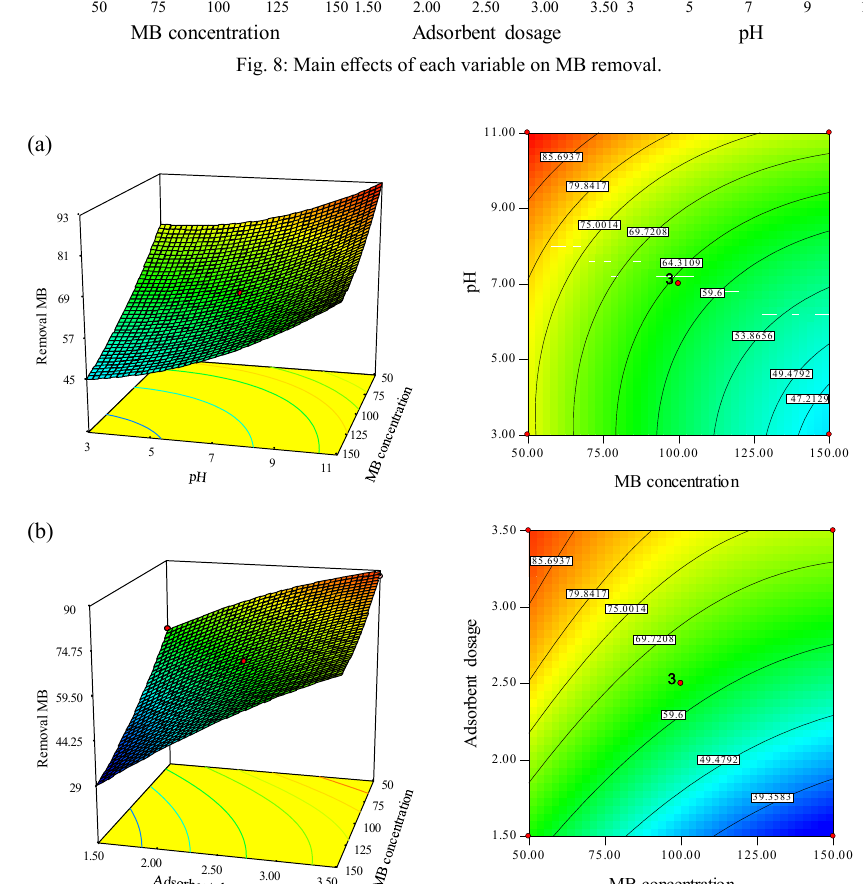
Fig. 9: Contours and response surface plots for MB removal as a function of (a) MB concentration vs. pH at adsorbent dosage=2.50 g L -1 (b) MB concentration vs. adsorbent dosage at pH=7.